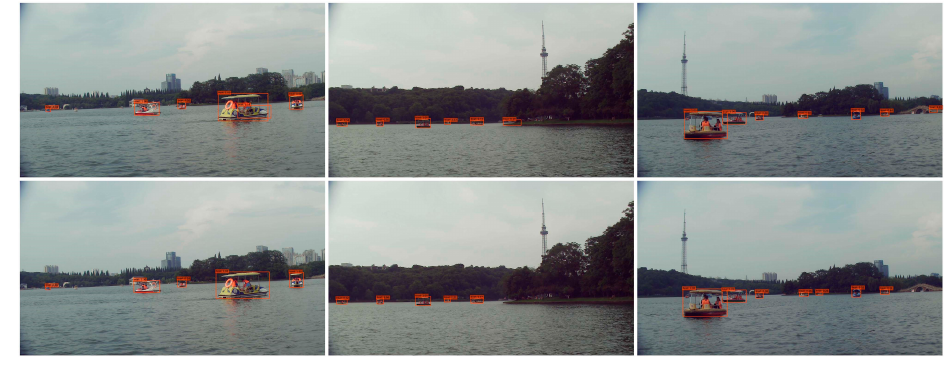
Figure 9. Visualization of results on LAKE-BOAT. The second row of each subfigure shows the detection results of FASSD.